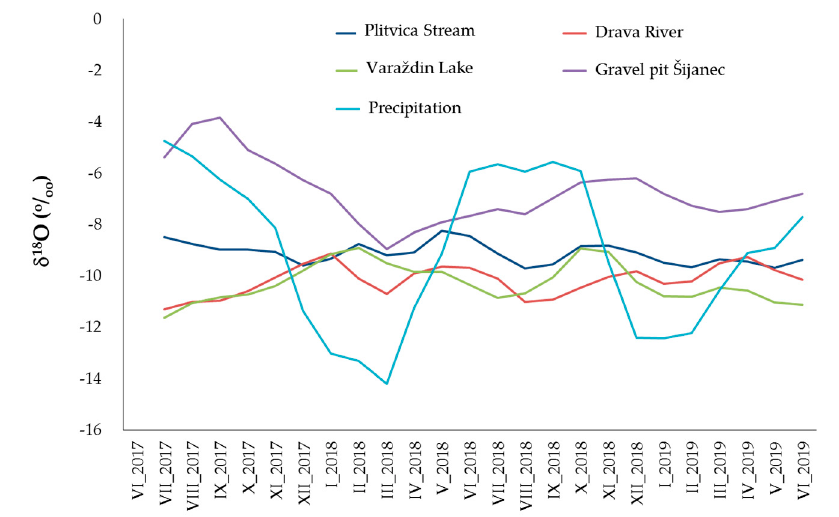
Figure 7. Distribution of δ 18 Ο ( o / oo ) values in surface waters over the monitored time.